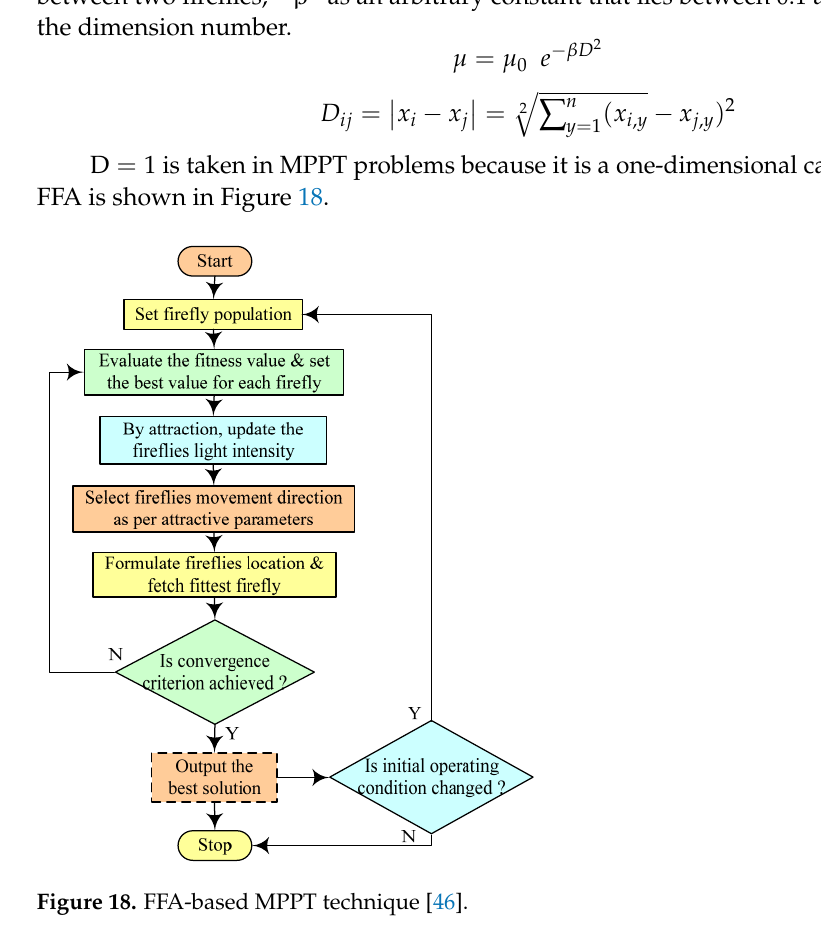
Figure 18. FFA-based MPPT technique